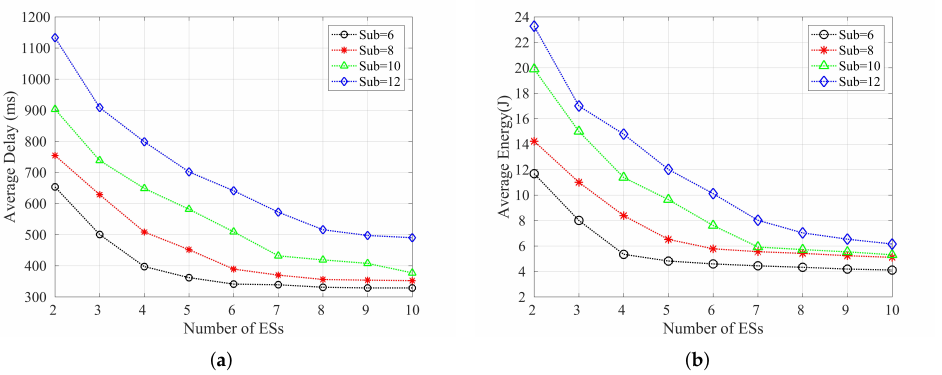
Figure 7. Variation of the average delay and the average energy consumption with the number of edge servers when the number of subtasks is {6, 8, 10, 12} respectively; ( a ) Average delay; ( b ) Average energy